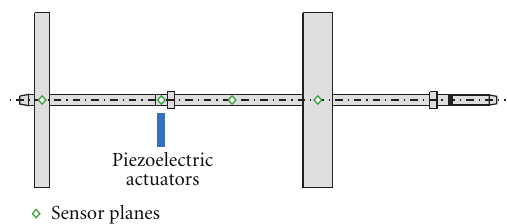
Figure 5: An 8-sensor configuration of the test rig for